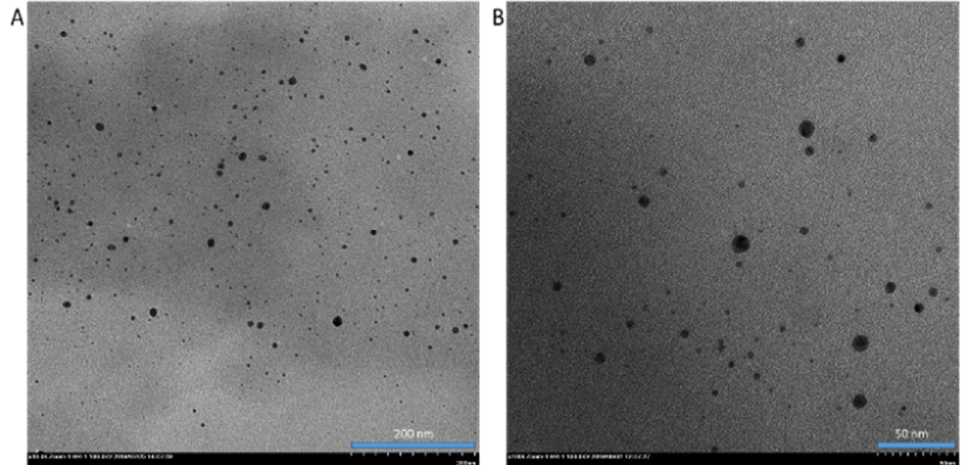
Figure 12. TEM micrographs of 2-AST silver nanoparticles in toluene with n-butylsilane as phase transfer molecule. (( A ) 40.0 k zoom. ( B ) 100.0 k zoom).